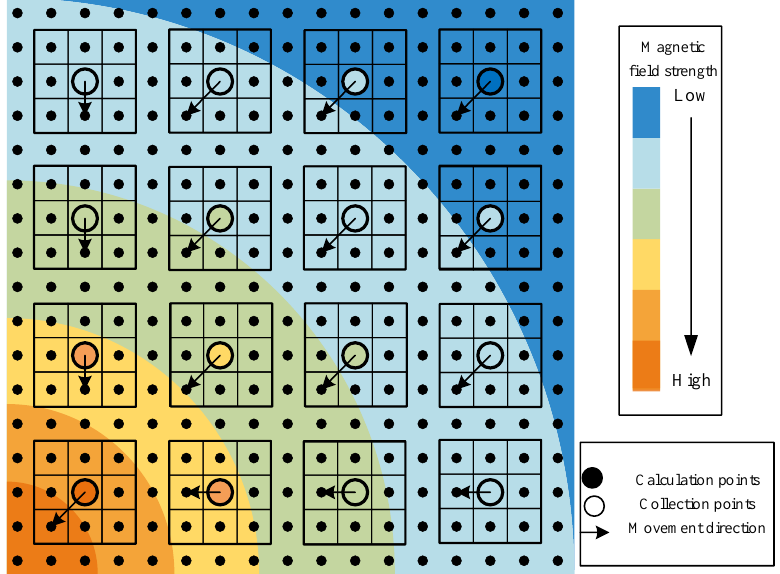
Figure 13. Magnetic cloud map and data collection point schematic diagram.